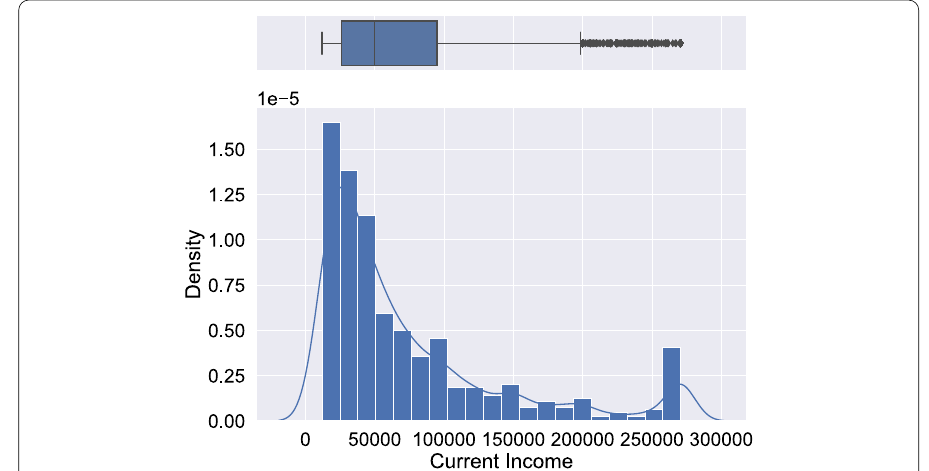
Fig. 2 Density bar plot and boxplot of the winsorized result of the Current Income variable